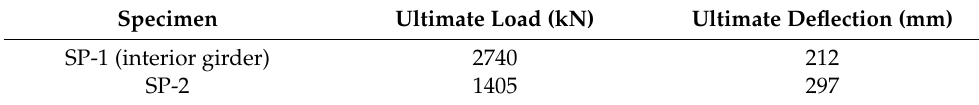
Table 5. Comparison of the load–deflection values for exterior girder of specimen SP-1 and speci- men SP-3 under service loads.